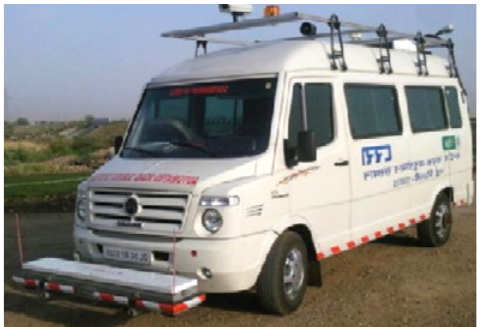
Figure 2. Ravelling on pavement section NH-8GJ at 434.00 km